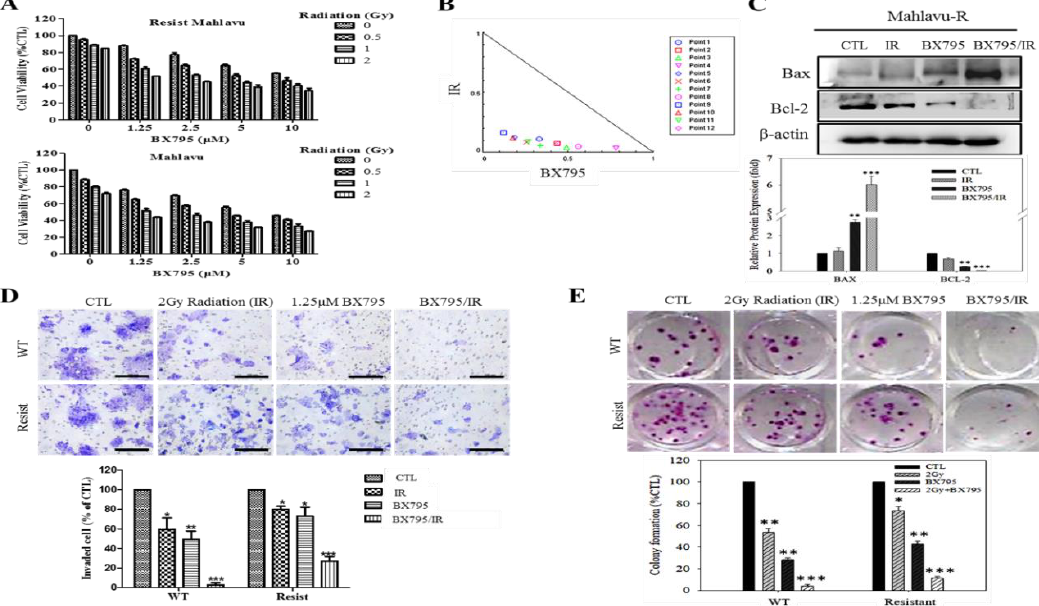
Figure 5. BX795-mediated pharmacologic targeting of PDK1 resensitizes HCC cells to radiotherapy-induced apoptosis signals dose-dependently and significantly suppresses their oncogenicity. ( A ) Histograms of the e ff ect of 24 h exposure to 0.5–2 Gy IR on the viability of IR-resistant (upper panel) or wild-type (lower panel) Mahlavu cells. ( B ) Isobologram indicating synergism between di ff erent doses of IR and BX795. ( C ) The e ff ect of exposure to 2 Gy IR, 1.25 µ M BX795 or 2 Gy IR + 1.25 µ M BX795 on the expression level of Bax and Bcl-2 proteins in Mahlavu-R cells as shown by Western blot analyses. Photo-images (upper panel) and histograms (lower panel) comparing the e ff ect of exposure to 2 Gy IR, 1.25 µ M BX795 or 2 Gy IR + 1.25 µ M BX795 on the ( D ) invasion, and ( E ) colony formation potential of WT or IR-resistant Mahlavu cells. β -actin was used as a loading control. Scale bar: 100 µ m, 10 × objective; * p < 0.05, ** p < 0.01, *** p < 0.001; Resist, IR-resistant; WT, wild-type; CTL,